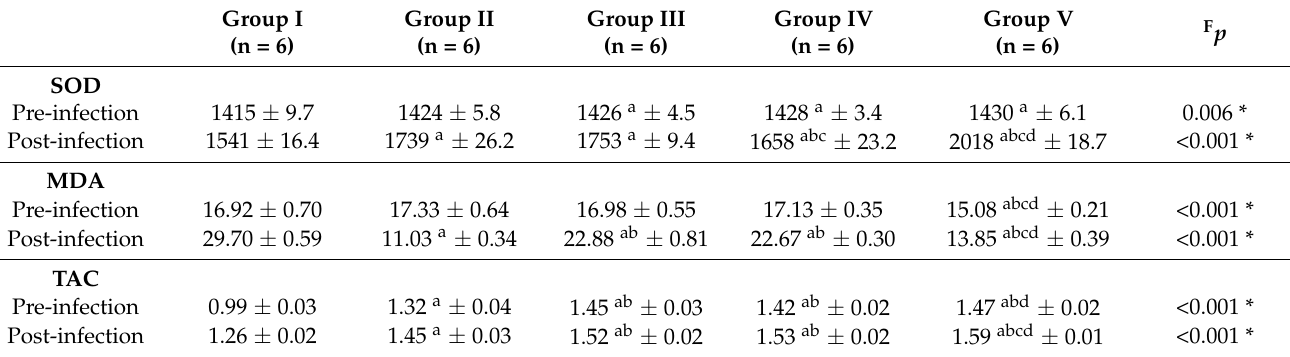
Table 2. The mean SOD (U/g tissue), MDA (nmol/mg) levels in brain homogenates, and TAC levels (mM/L) in sera of various evaluated regimens at different